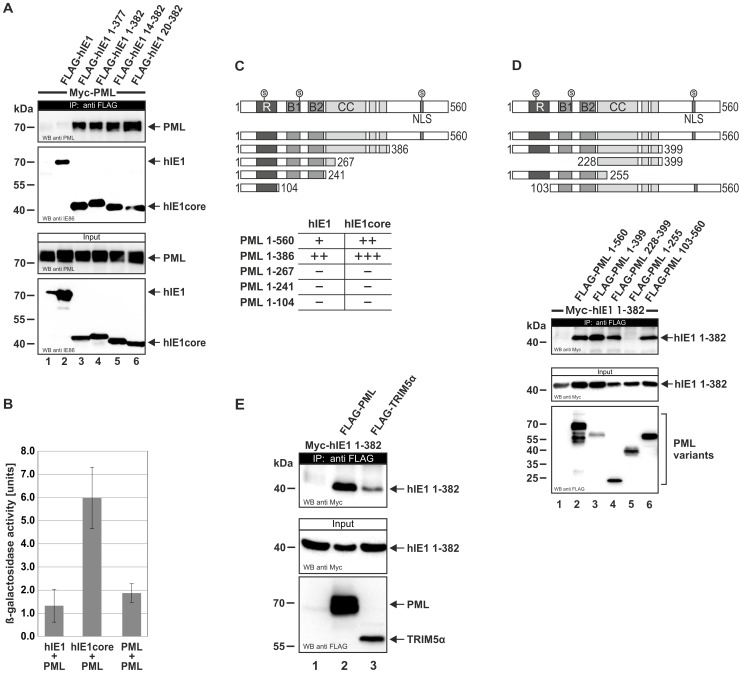
Interaction of IE1CORE with PML and TRIM5α.(A) Enhanced binding of IE1CORE to PML in coimmunoprecipitation analysis. HEK293T cells were cotransfected with expression plasmids encoding FLAG-hIE1 variants (as indicated) and Myc-PML (isoform VI). Upper two panels: Western blot detection of PML and hIE1 after immunoprecipitation with an anti-FLAG antibody. Lower two panels: detection of PML and hIE1 in cell lysates before precipitation (input). (B) Enhanced binding of IE1CORE to PML in yeast two-hybrid assays. The graph shows the quantification of β-galactosidase reporter activity after coexpression of PML and full-length hIE1 or the hIE1CORE(14–382) in yeast cells. (C) The PML coiled-coil is required for IE1 binding in yeast two-hybrid assays. Full-length hIE1 and hIE1CORE(14–382) were tested for interaction with various C-terminal PML deletion mutants (shown in the upper scheme) by XGal filter lift assays. (D) The PML coiled-coil is sufficient for binding to hIE1CORE in coimmunoprecipitation analysis. HEK293T cells were transfected with various FLAG-tagged PML deletion mutants, as shown in the upper scheme, together with Myc-hIE1CORE(1–382). Upper panel: Western blot detection of hIE1CORE after immunoprecipitation with an anti-FLAG antibody. Lower two panels: Western blot detection of PML variants and hIE1CORE in cell lysates before precipitation (input). (E) Interaction of hIE1CORE with TRIM5α. HEK293T cells were cotransfected with expression plasmids encoding Myc-tagged hIE1CORE(1–382) and either FLAG-tagged PML (isoform VI) or FLAG-tagged rhesus macaque TRIM5α (rhTRIM5α). Upper panel: Western blot detection of hIE1CORE after coimmunoprecipitation using an anti-FLAG antibody. Lower two panels: Western blot detection of PML, rhTRIM5α and hIE1CORE in cell lysates before precipitation (input). R, RING domain; B, B-boxes; CC, coiled-coil domain; NLS, nuclear localization signal; S, SUMO.